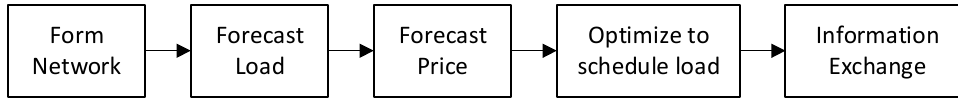
Figure 1. Operation process and information flow of the agents.